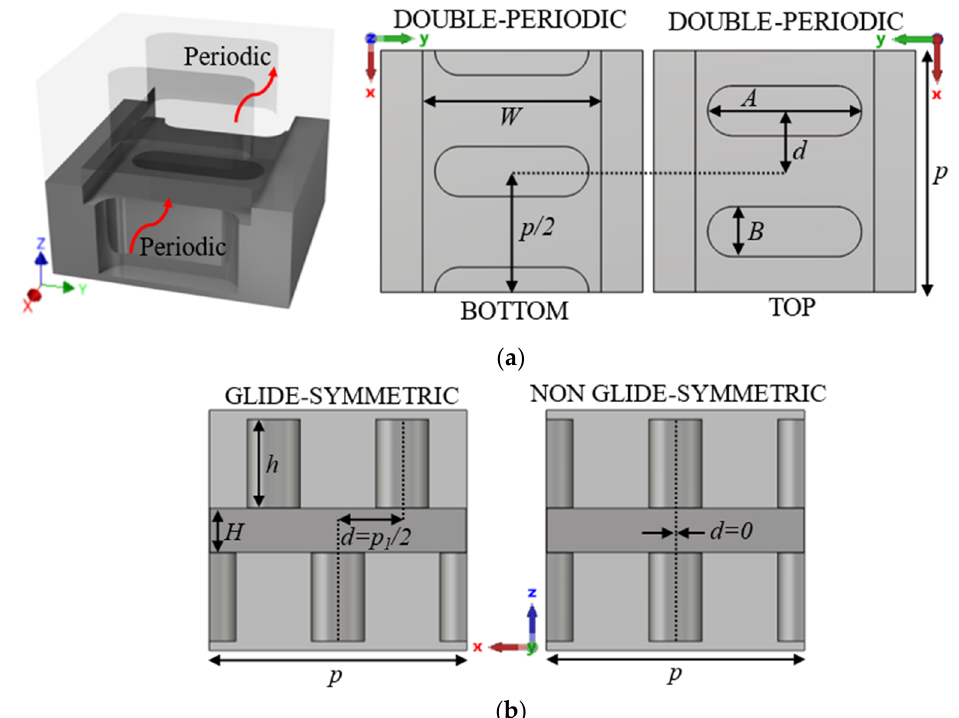
Figure 16. Double periodicity ideal unit cell. ( a ) Perspective, bottom and top views and ( b ) lateral view in glide and non-glide symmetric positions. Periodic in x -direction.